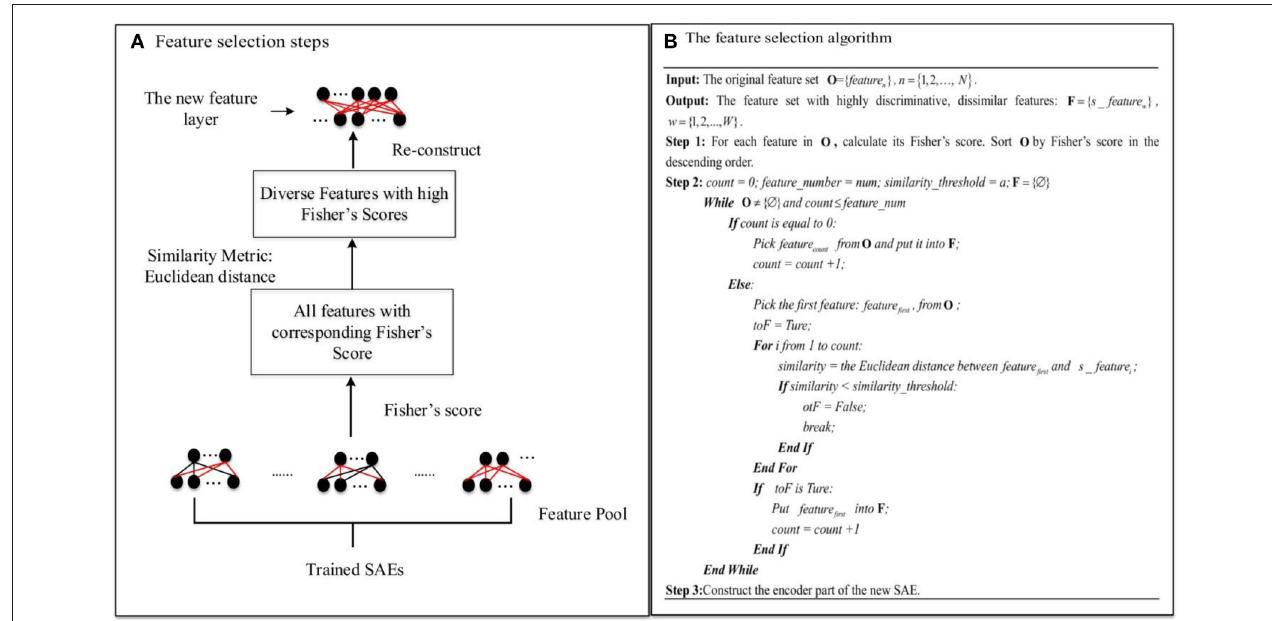
FIGURE 4 | The novel feature selection method: (A) Feature selection steps. (B) The feature selection